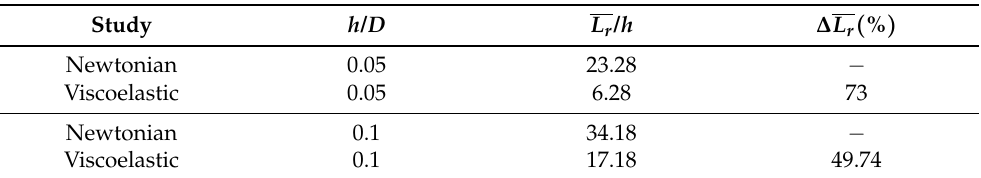
Table 3. The mean recirculation length ( L r / h ) for Newtonian and non-Newtonian flows over rough- ness elements.